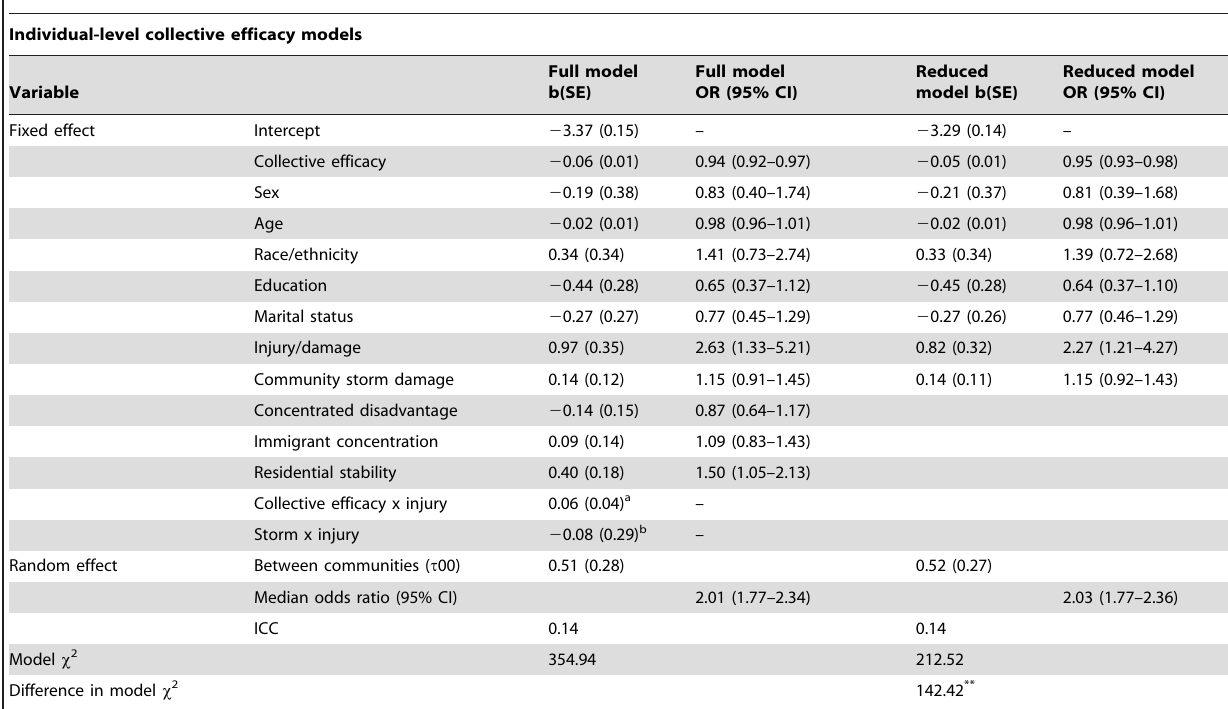
Table 4. Parameter estimates of multilevel logistic regression models for individual-level collective efficacy on probable PTSD